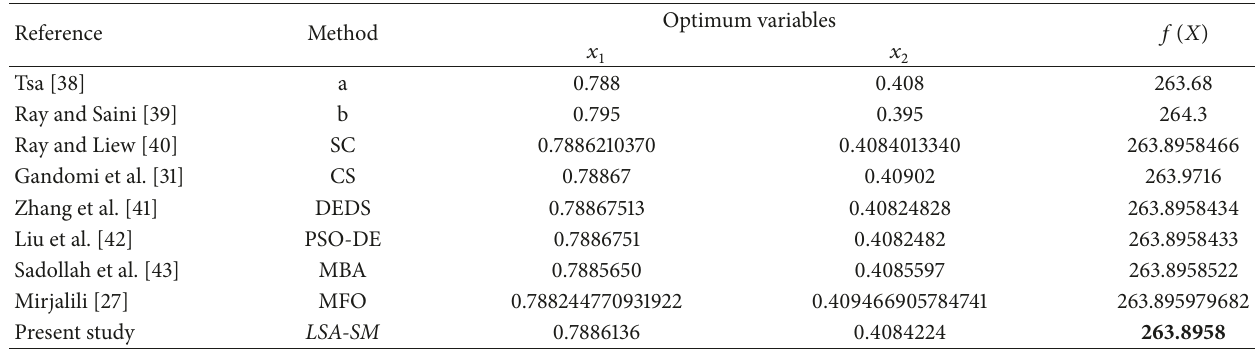
Table 12: Best results of the three-bar truss design by different methods.